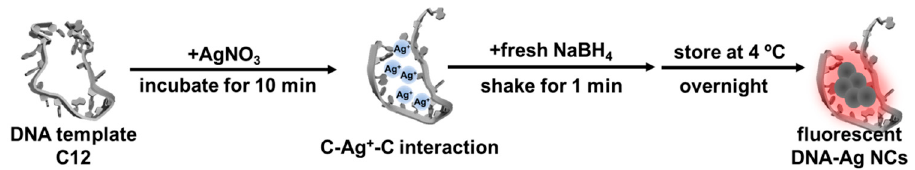
Figure 2. Illustration of the synthesis of C12-templated Ag nanoclusters (NCs).